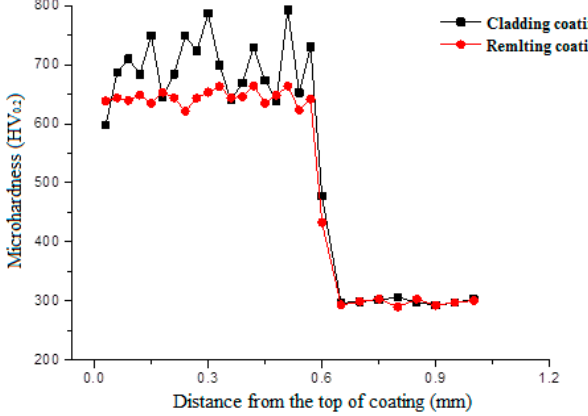
Figure 3. Microhardness distribution of coatings.